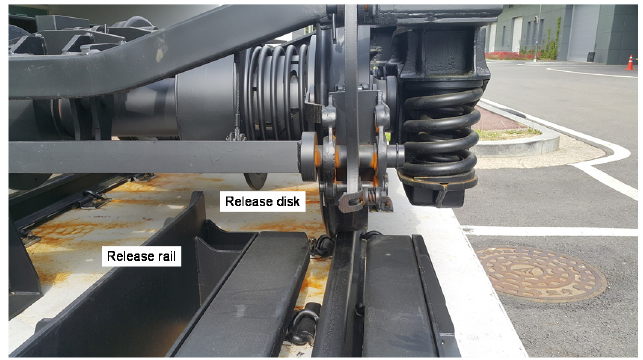
Figure 1. Variable gauge system of release rail and release disk.